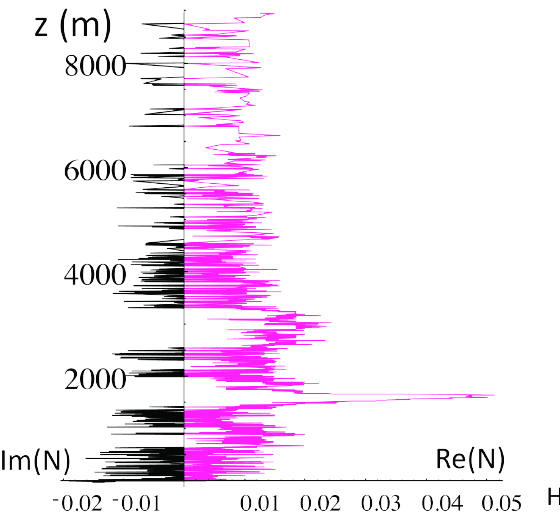
Fig. C1. This shows the Brunt–Vaisälä frequency N (in Hz) as esti- mated by a single dropsonde over the Pacific; only estimates across layers <20 m thick were used, and it was typical of the 238 son- des analysed in the Pacific 2004 experiment. Analysis of dropsonde pairs (Lovejoy et al., 2008a) indicated that the measurement errors are less than the thickness of the lines. The right-hand side shows the real part, the left hand side the negative of the imaginary part (these unstable layers constituted 15% of the all the values, and this was typical).